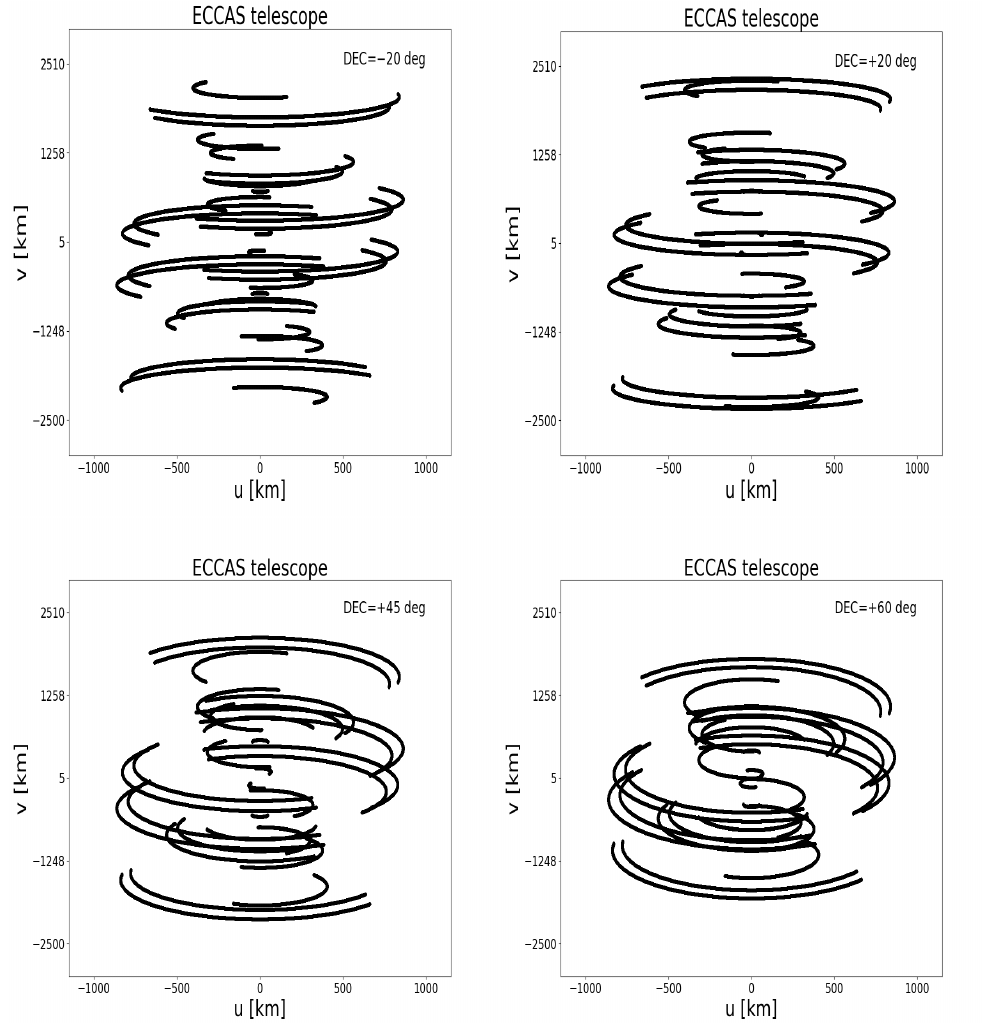
Figure 4. ECCAS antennas uv -coverage at 1.4 GHz at four declinations ( − 20, + 20, + 45, and + 60 deg), 10 h observation, and 16 MHz total bandwidth showing a lot of holes or